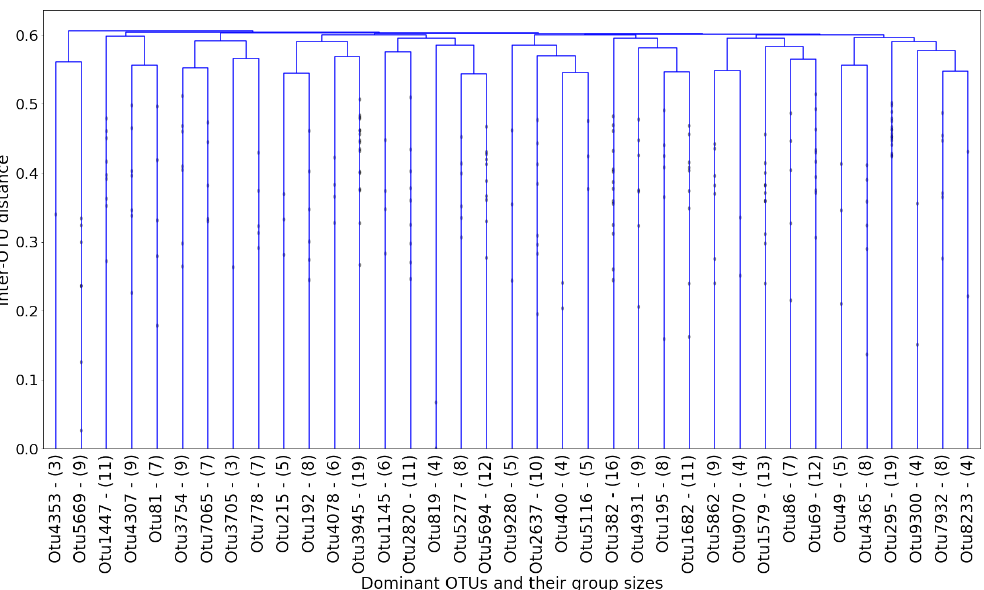
Figure 11. Dendrogram of the UPGMA hierarchy with optimal distance cut-off, at a depth of K = 37 groups. Each branch is labelled with the dominant OTU, and the number of its followers.